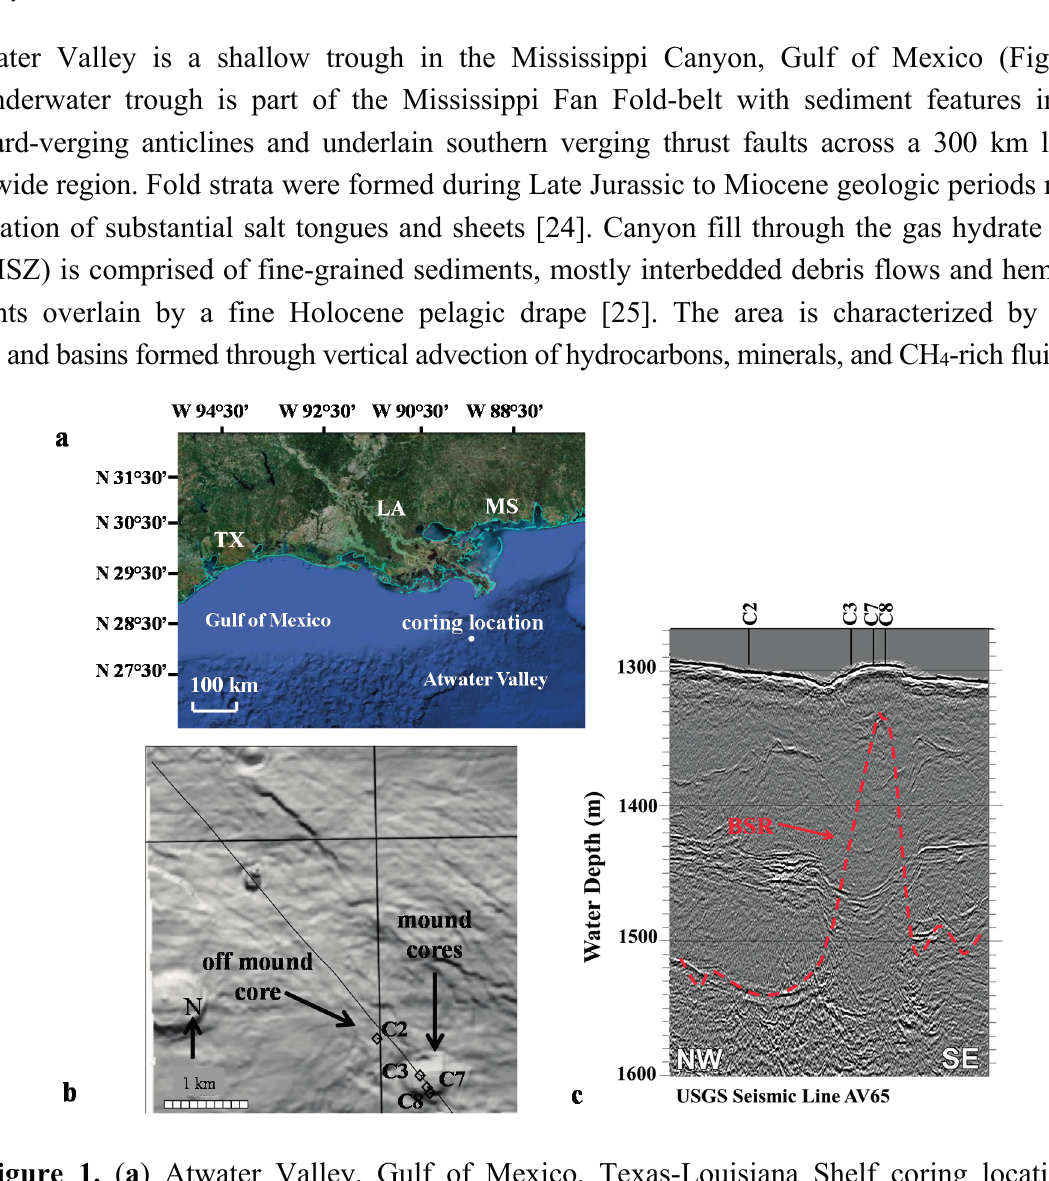
Figure 1. ( a ) Atwater Valley, Gulf of Mexico, Texas-Louisiana Shelf coring location (provided by Google Earth); ( b ) Sediment floor contours through the sample region, with sites on- (cores 3,7,8) and off-mound (core 2), the solid line represents the seismic data transect through the coring locations; ( c ) Core sites selected for this study were over a strong sediment bottom reflection (BSR) off-mound and on the mound observed with an elevated BSR and vertical seismic blanking above the BSR